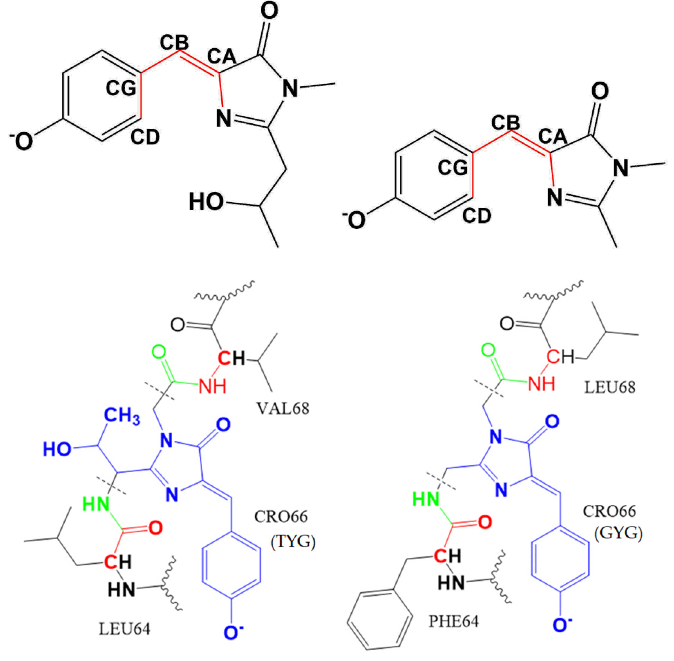
Figure 5. Top: Structures of the model TYG (EGFP, YFP-G65T) (left) and GYG (YFP, EGFP-T65G) (right) chromophores. Torsional angles ϕ and τ are defined as CD-CG-CB-CA and CG-CB-CA-N, respectively. The difference between the two angles Δ = ϕ − τ quantifies whether the chromophore is planar ( Δ = 0) or not. Bottom: the QM/MM partitioning for EGFP (left) and EYFP (right). Blue color denotes the QM region and the black dotted lines denote the QM–MM boundary. Charges of red and green atoms were set to zero in the MM region. In EGFP-T65G, the chromophore is GYG and the neighboring residues are the same as in EGFP. Likewise, in EYFP-G65T, the chromophore is TYG and the neighboring residues are the same as in EYFP. We begin with characterization of the bare model chromophores. Figure 5 shows the structures of the isolated model chromophores and defines important structural parameters; it also shows how the chromophores are connected to the protein backbone. As one can see, the conjugated core of the